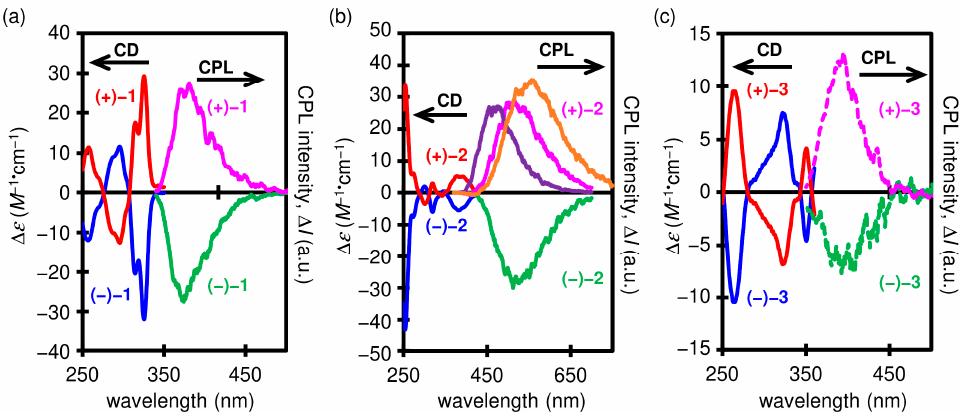
Figure 6. CD and CPL spectra of ( a ) 1 , ( b ) 2 , and ( c ) 3 in CH 2 Cl 2 (red and blue lines for CD; pink and green lines for CPL; purple and orange lines in ( b ) for CPL in toluene and acetonitrile, respectively). Table 2. Chiroptical date of spiro-fused PACs 1 – 3 in CH 2 Cl 2 .